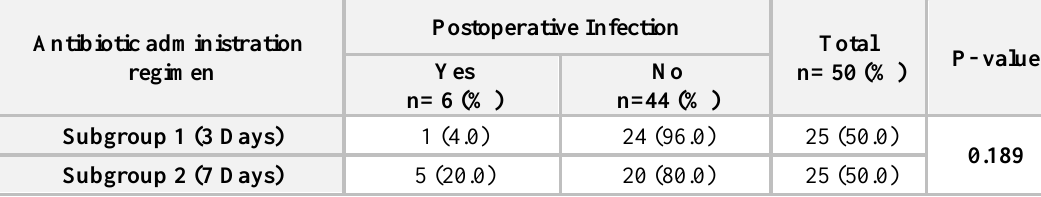
Table (5): Association between antibiotic administration regimen (three or seven days